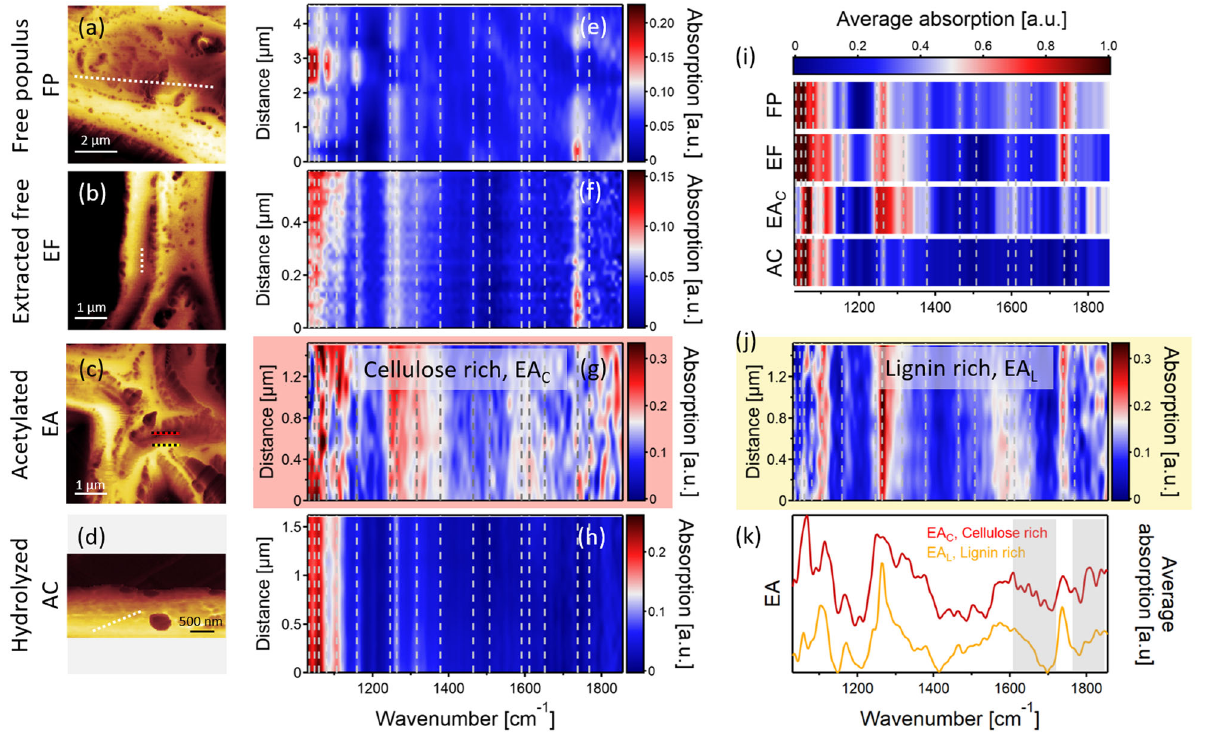
Fig. 4 Nanospectroscopic process monitoring via infrared absorption mapping. Re fl ectivity images ( a – d ) along the deligni fi cation process. The associated chemical compositions ( e – h ) extracted from the absorption images are mapped along the lines in the S2 region of the cell wall in a – d . For the EA sample, both cellulose-rich (EA C , g , red) and lignin-rich (EA L , j , yellow) regions were investigated (see Fig. 3c). i The average absorption for the FP, EF, EA C , and AC samples was normalized by the intensity of the cellulose characteristic absorption band at 1059 cm − 1 . In all mappings, the dotted lines indicate the wavenumbers of the absorption bands of interest corresponding to cellulose, hemicellulose, lignin, and fats, see Table 1. k Average absorption spectra obtained for the EA C and EA L regions. The bands in the range 1600 – 1720 cm − 1 and above 1750 cm − 1 (shaded areas) re fl ect the success of acetylation in the cellulose-rich regions (EA C